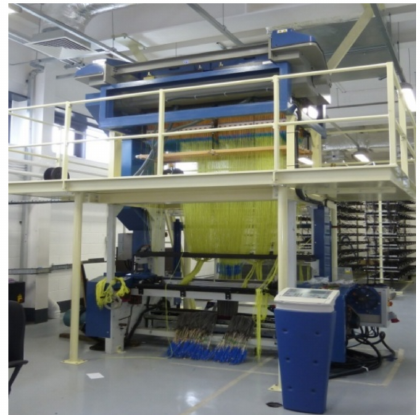
Figure 3. Jacquard loom.